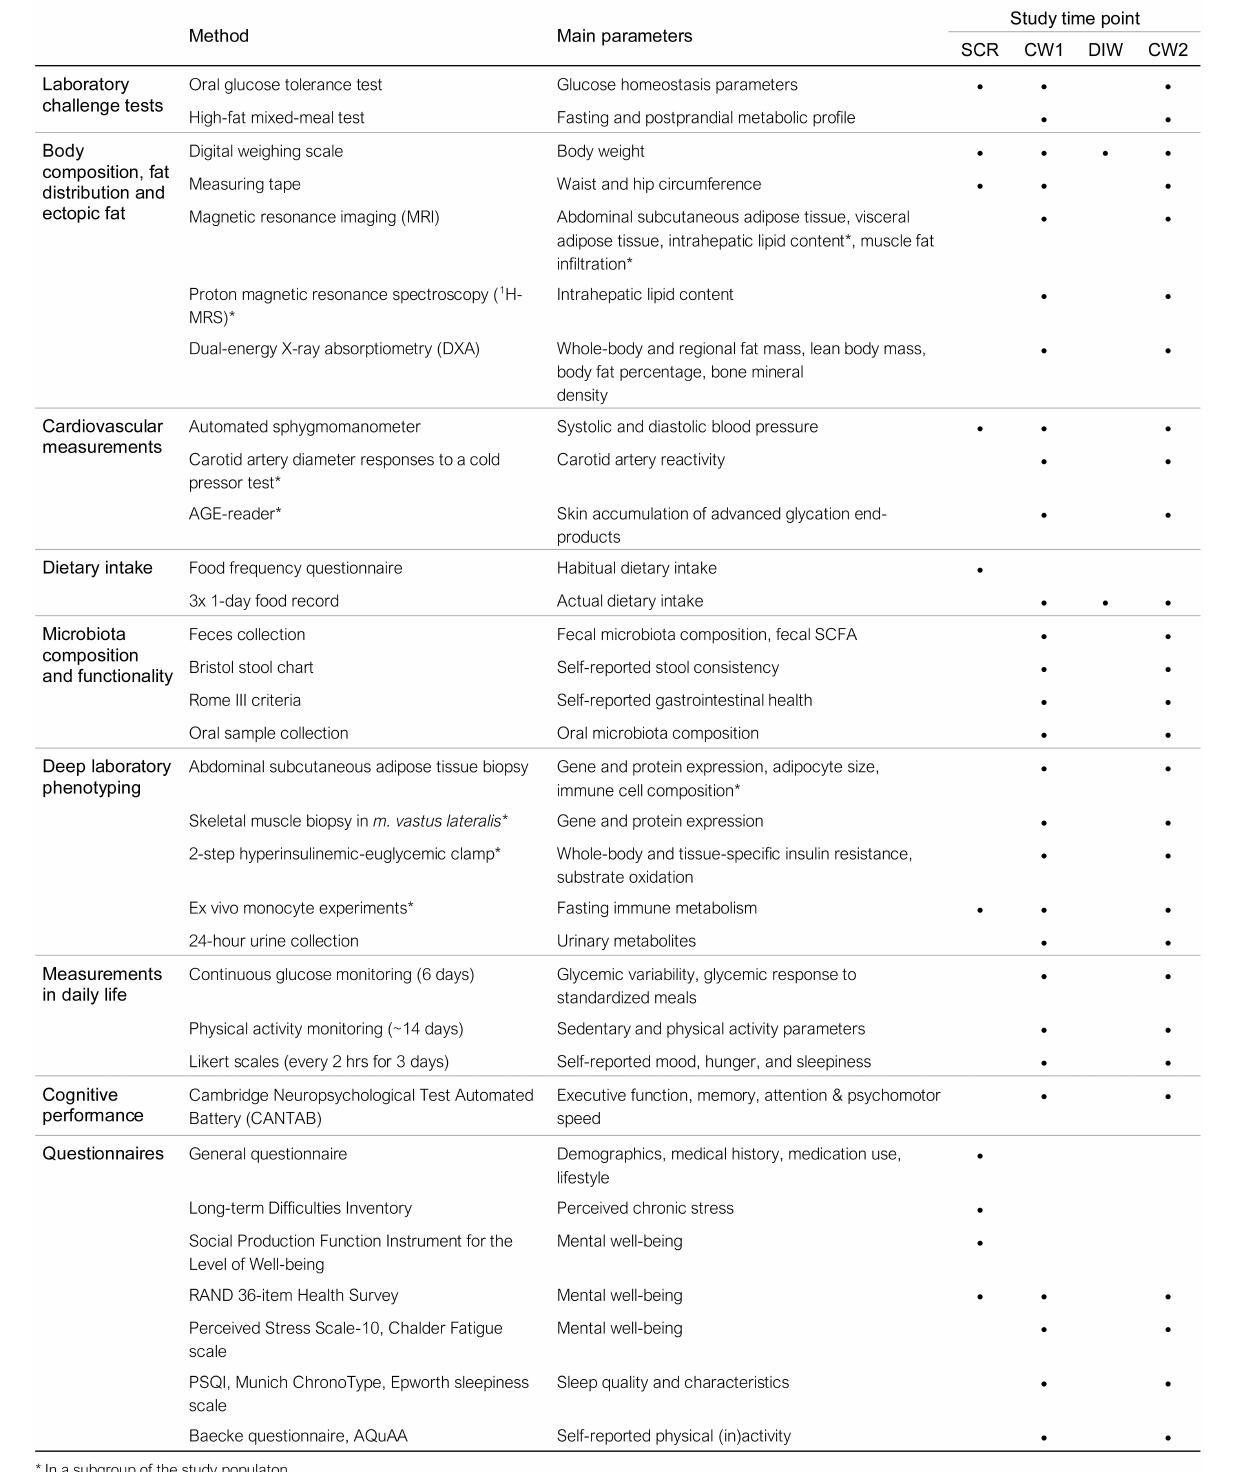
FIGURE 3 | Overview of all measurements performed within the PERSON study. *Performed in a subgroup of the study population. SCR, screening visit; CW, characterization week; DIW, dietary intervention week.